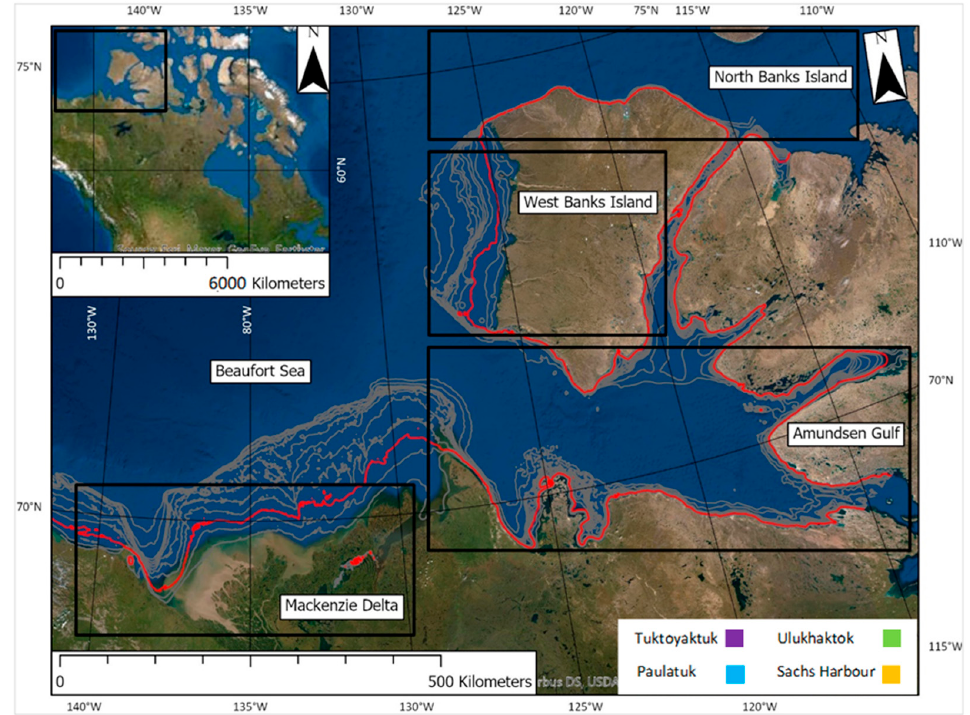
Figure 1. This Northwest Canadian Arctic study area covers ≈ 3200 km of permafrost coastlines. Four regions have been identified for the purpose of this study: Mackenzie Delta ( ≈ 482 km), Amundsen Gulf ( ≈ 1854 km), West Banks Island ( ≈ 275 km), and North Banks Island ( ≈ 216 km). Example communities with nearby weather stations used for analysis of dynamic controls are shown with coloured boxes: Tuktoyaktuk (purple), Paulatuk (blue), Ulukhaktok (green), and Sachs Harbour (yellow). The red line indicates the 30 m isobath and shows its spatial variability across the study area, the brown lines represent the bathymetric range from 10 m to 30 m; these were extracted using the GEBCO_2021 Grid [53].